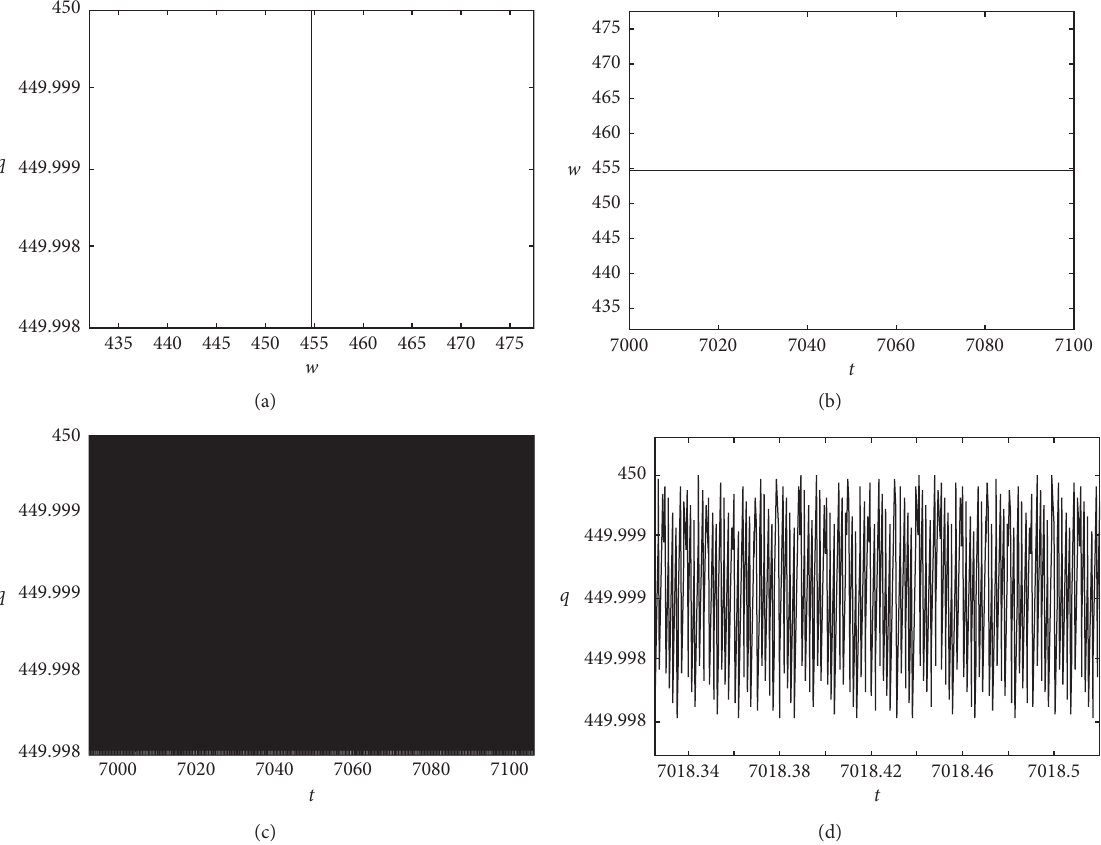
Figure 9: The more irregular oscillation in system (10), where the phase portrait is in (a), time histories in (b) and (c), and (d) is the local magnification of (c).